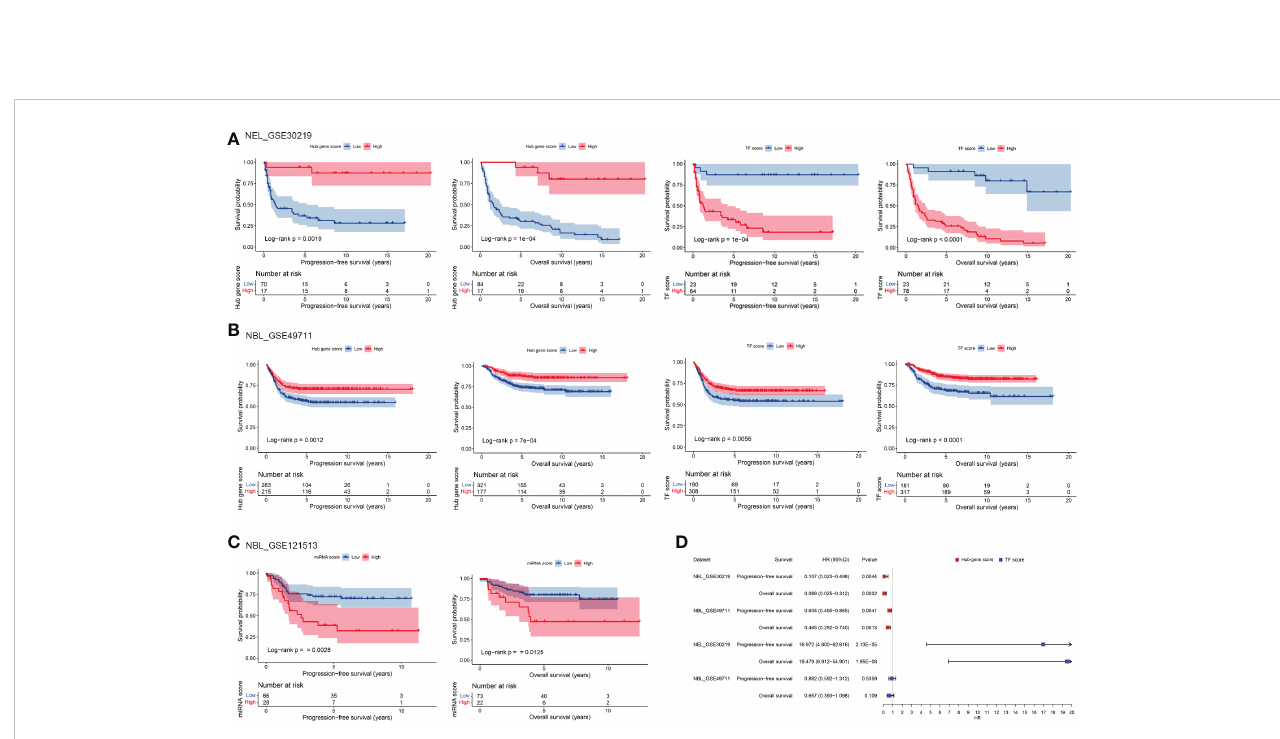
FIGURE 8 Prognostic potential of TF, mRNA and miRNA scores in TF-mRNA-miRNA network for MTC. The in fl uence of hub-gene and TF scores on the survival of NEL (A) and NBL (B) based on univariate analysis. (C) The in fl uence of miRNA score on the survival of NBL based on univariate analysis. (D) The in fl uence of hub-gene and TF scores on the survival of neuroendocrine tumors with the adjustment of stromal score, immune score and tumor purity based on multivariate analysis. NEL, neuroendocrine tumor of lung; NBL,